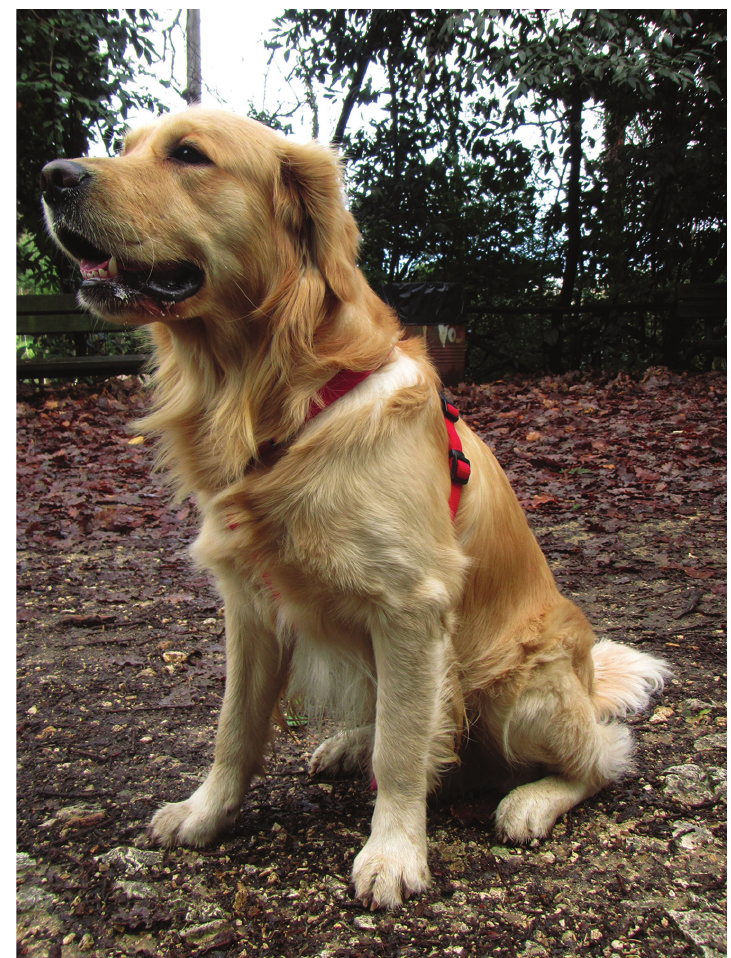
Figure 1. Teseo wearing the harness (Photo by Fabio